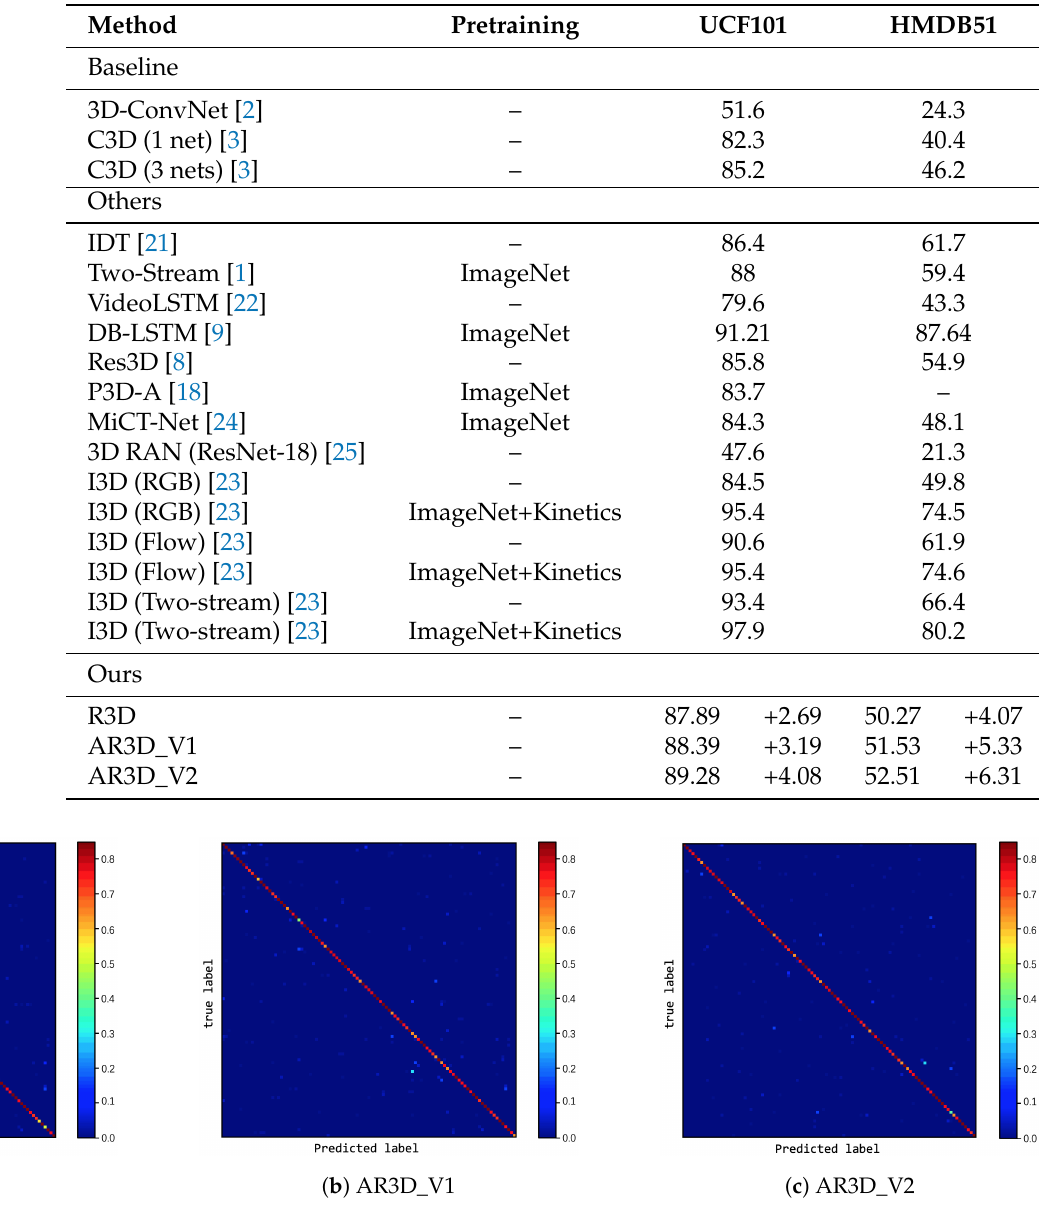
Table 4. The recognition accuracy of all models on UCF101 and HMDB51.